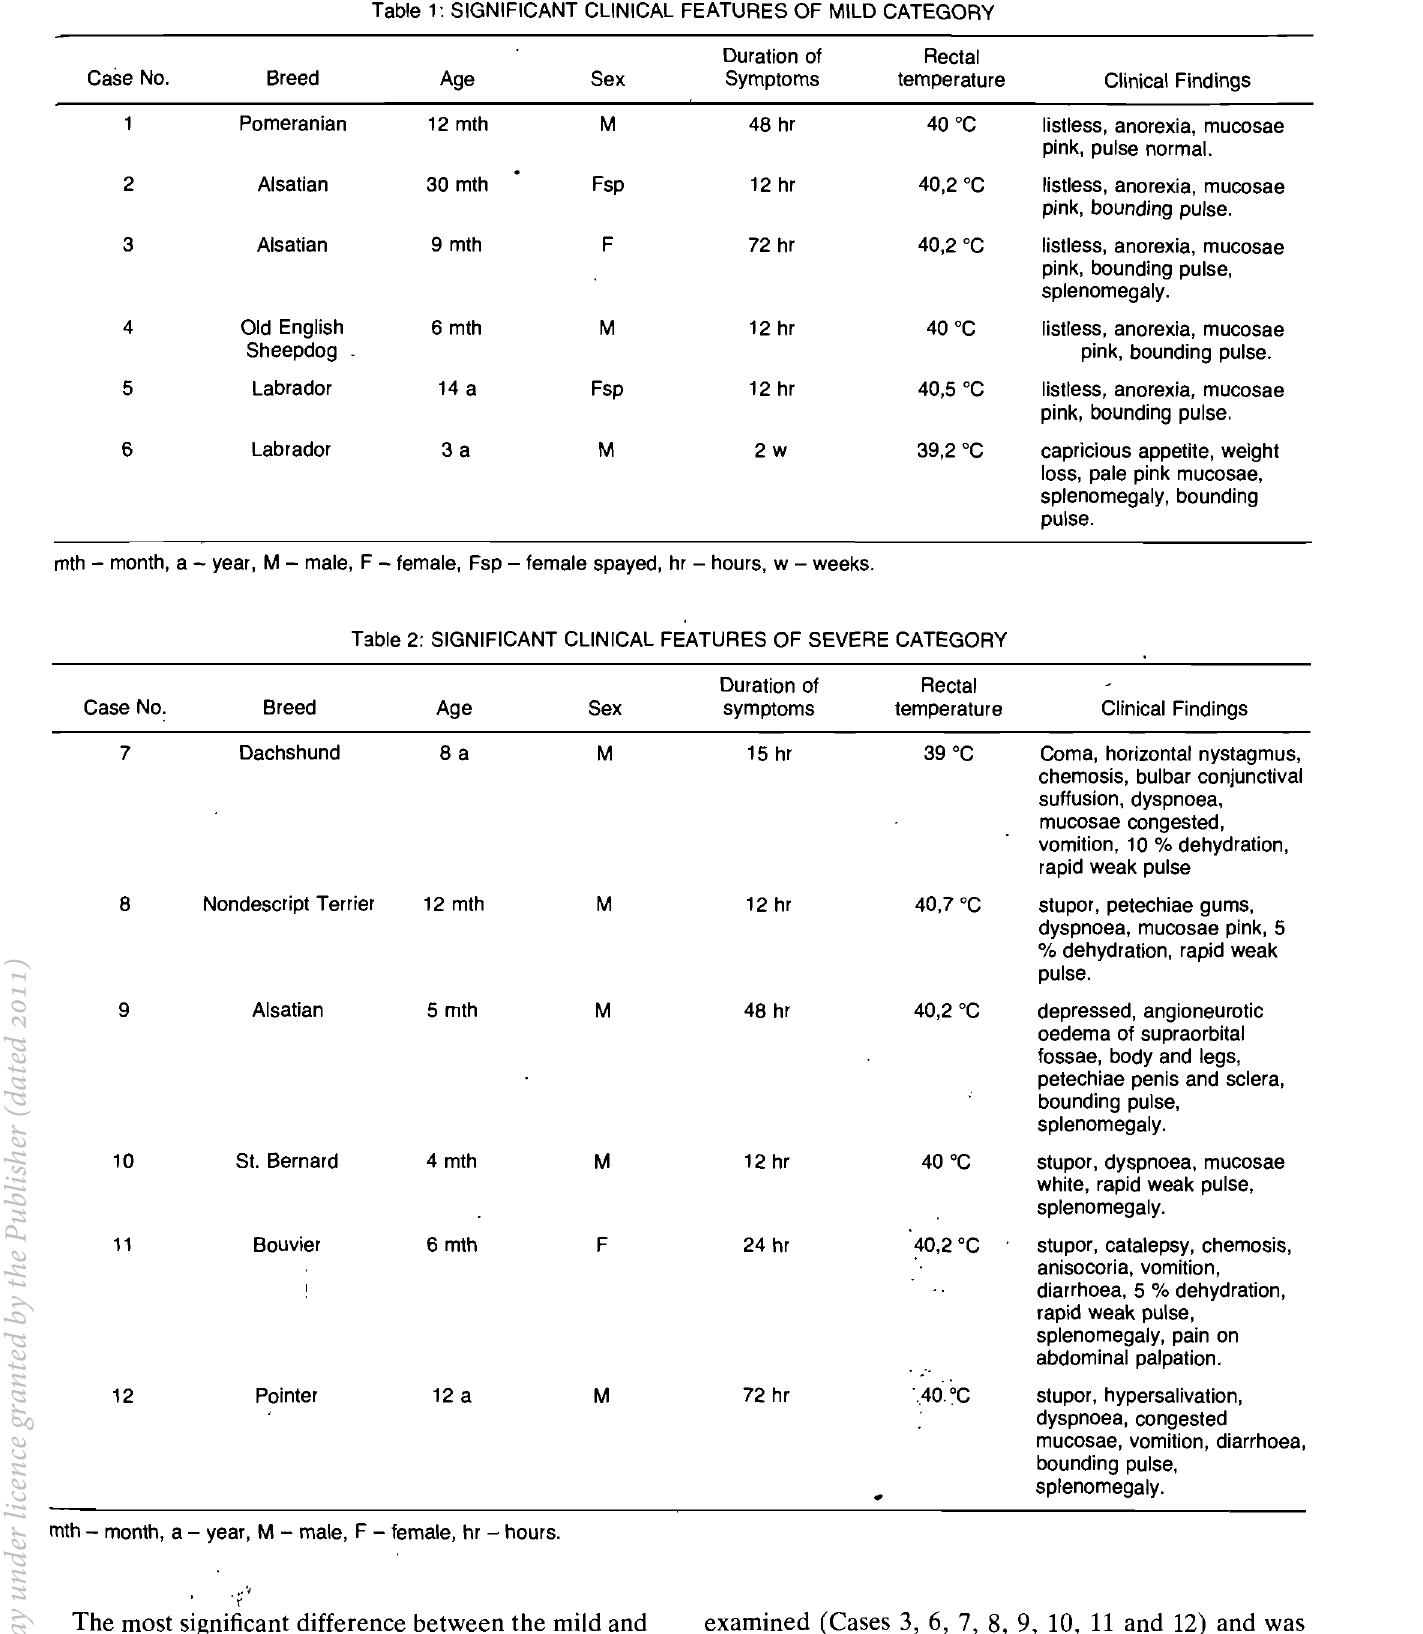
Duration of Rectal